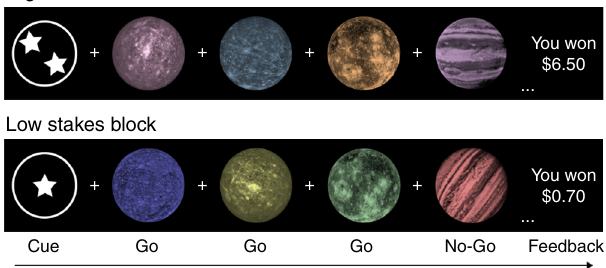
Fig. 1 Planets task. Participants viewed a low stakes or high stakes cue followed by a series of eight target trials. In this example, participants were instructed to press a button for go trials (planets with craters) and withhold a response for no-go trials (planets with stripes). Correct responses were rewarded with $1.00 in high stakes and $0.20 in low stakes. Incorrect responses incurred a loss of $0.50 for high stakes and $0.10 for low stakes. Performance-contingent feedback was displayed at the end of a